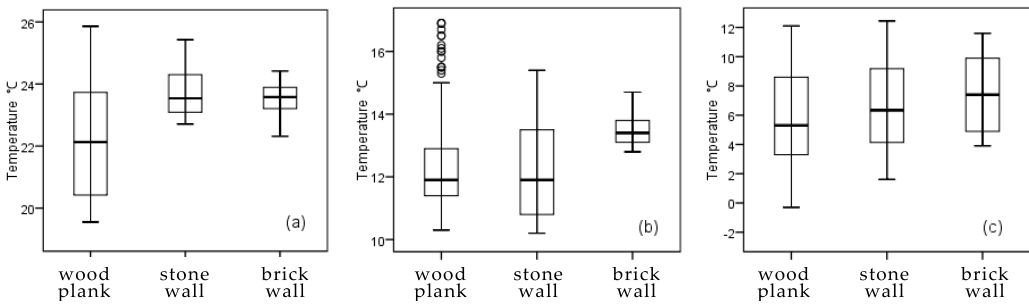
Figure 15. Air temperature distributions from: ( a ) 22–28 August 2011 (summer); ( b ) 12–20 April 2012 (transition season); and ( c ) 26–28 January 2013 (winter). Bedroom FF represents measuring point H and bedroom GF represents measuring point E.